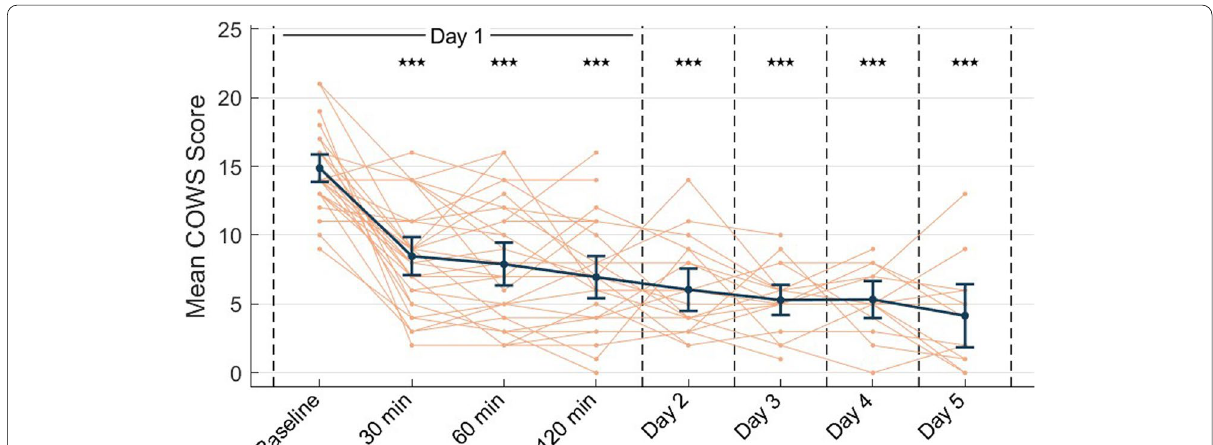
Fig. 4 COWS Scores Across Time in the Pooled Population Without Data Imputation. Legend: *** denotes p < 0.0001. Timepoints denote the number of minutes from the start of active tAN, which is either at the start or end of the double-blind period, depending on group assignment. Dark blue line indicates the mean COWS score of study participants at each timepoint. Orange lines indicate individual participant COWS score at each timepoint